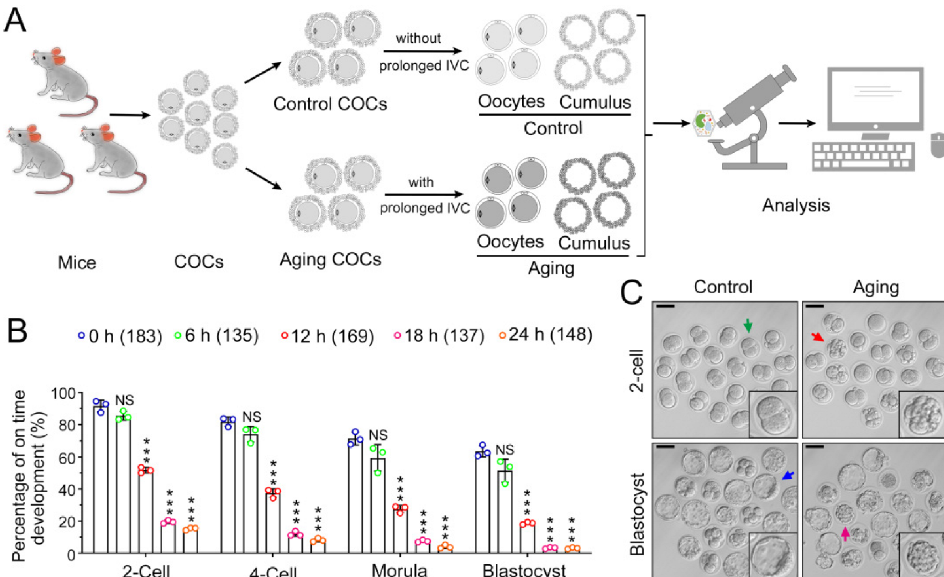
Figure 1. POA induces preimplantation embryo development failure. ( A ) Experimental design. The COCs were obtained from mice oviducts. All the COCs were collected for the pool and then were randomly selected and defined as the control group (without prolonged in vitro culture) or aging groups (with extended in vitro culture). The cumulus cells and oocytes were stripped after culture, and the two kinds of cells were separately collected for morphological detection, transcriptome analysis, and experiment verification. IVC: in vitro culture. ( B ) COCs underwent prolonged in vitro culture (0, 6, 12, 18, and 24 h) and IVF was performed. The percentages of fertilized oocytes developing into different stages were recorded. ( C ) Representative image of embryos at 24 h and 72 h after fertilization. Arrows indicate the embryo for enlargement. Green arrow indicates the normal 2-cells; red arrow indicates the degenerated embryos after fertilization; blue arrow indicates the developed blastocysts; pink arrow indicates the degenerated embryo. Scale bar = 100 µ m. The data are presented as mean ± SD. A culturing duration of 0 h served as the control group; groups with extension culture for 6, 12, 18, and 24 h were compared with the control group, respectively. No significant difference is indicated by NS ( p > 0.05) and a significant difference is shown by *** ( p < 0.001). The number of oocytes is shown in brackets in the